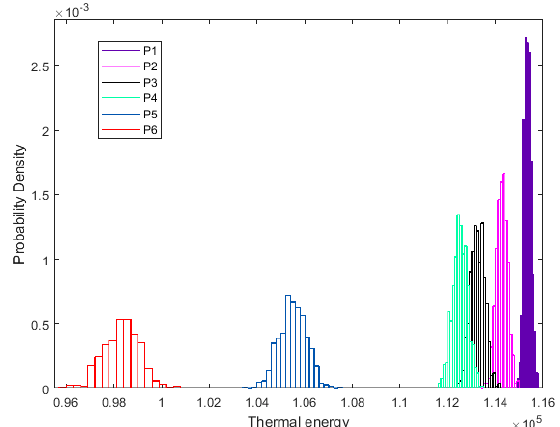
Figure 14. The histogram of probability density distribution of thermal energy in graphene with its heat source in armchair edges (P1–P6 represents the percentage of vacancy as 0.2%, 0.5%, 0.8%, 1%, 3%, and 5%, respectively, and the unit for thermal energy is J).